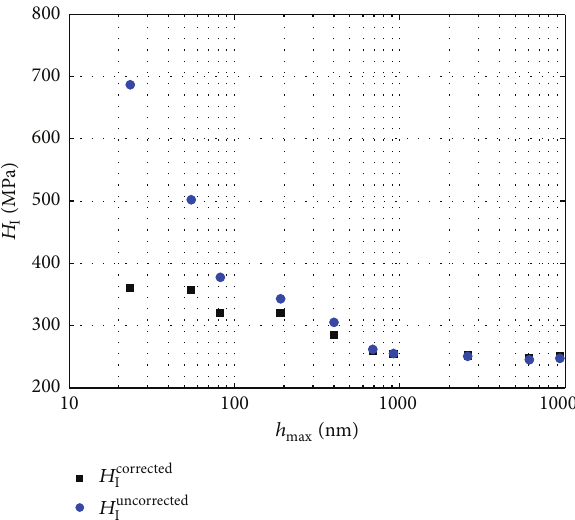
Figure 11: Indentation hardness of 20 phr epoxy after correction for theBauschingereffectwhere 𝜀 and 𝜀 o are,respectively,prestrainlevel and initial uniaxial yield strain [24].